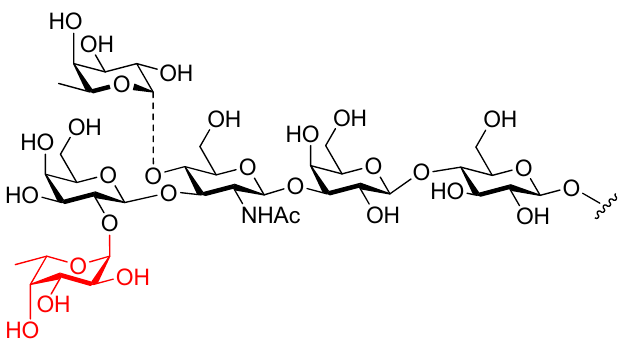
Figure 1. Highlighted in red is the fucose residue bound in CL2 of BabA [19].